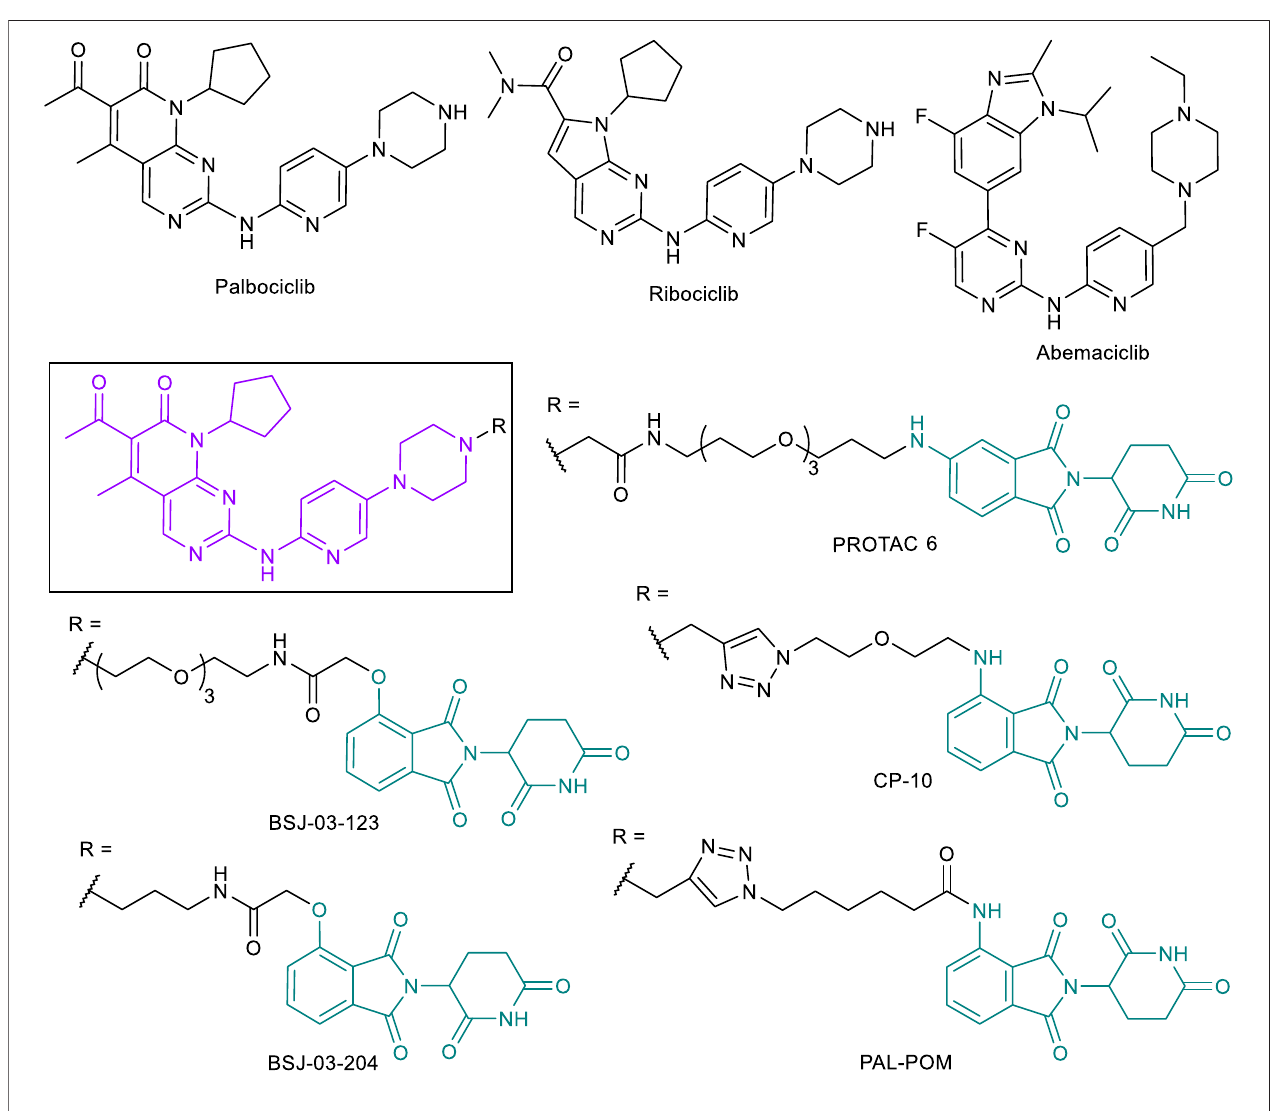
FIGURE 6 | Key CDK4/6 small molecule inhibitors and CDK4/6-targeted PROTACs.